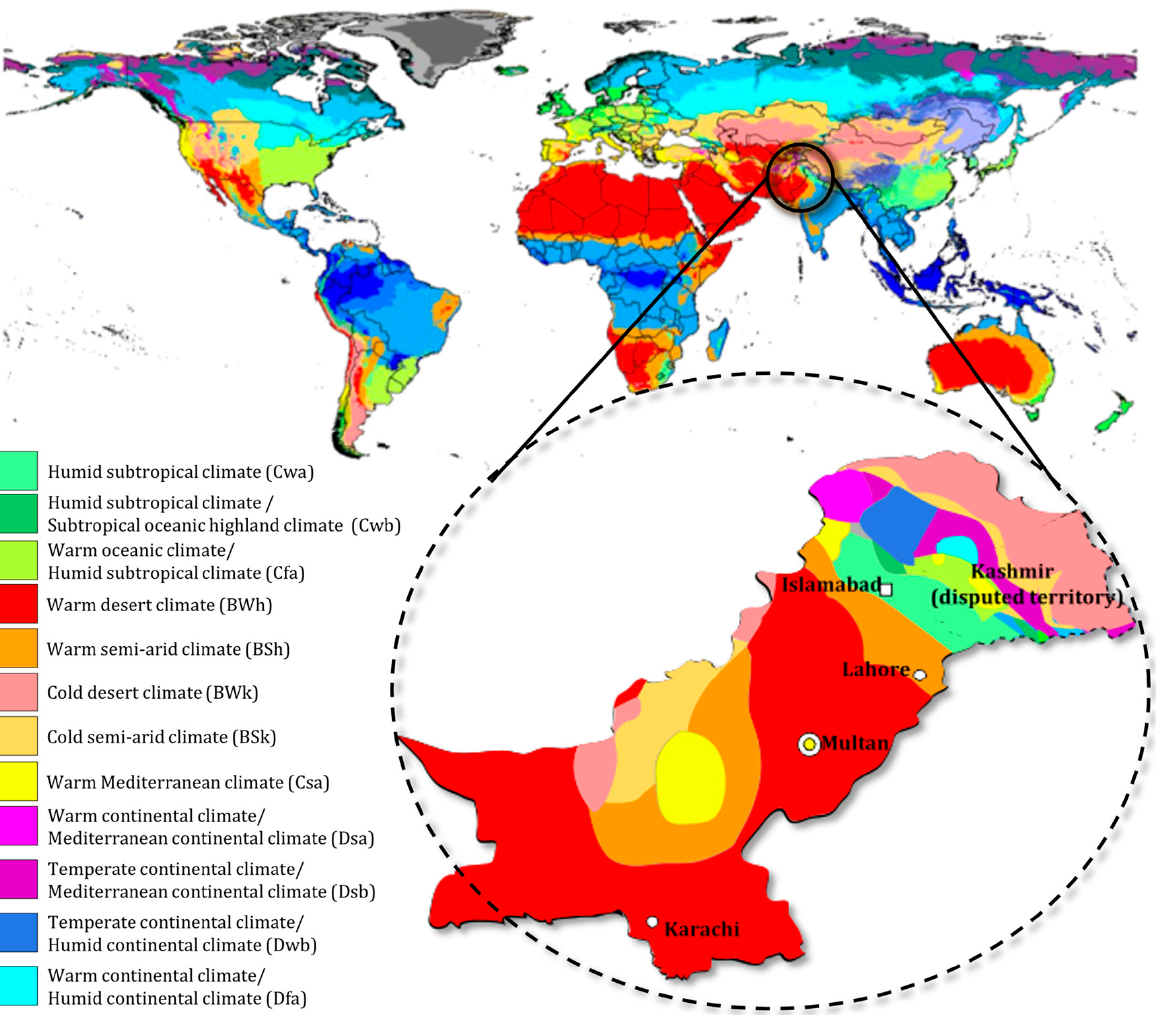
Figure 2. Köppen–Geiger climate classification of Pakistan, reproduced from [51].